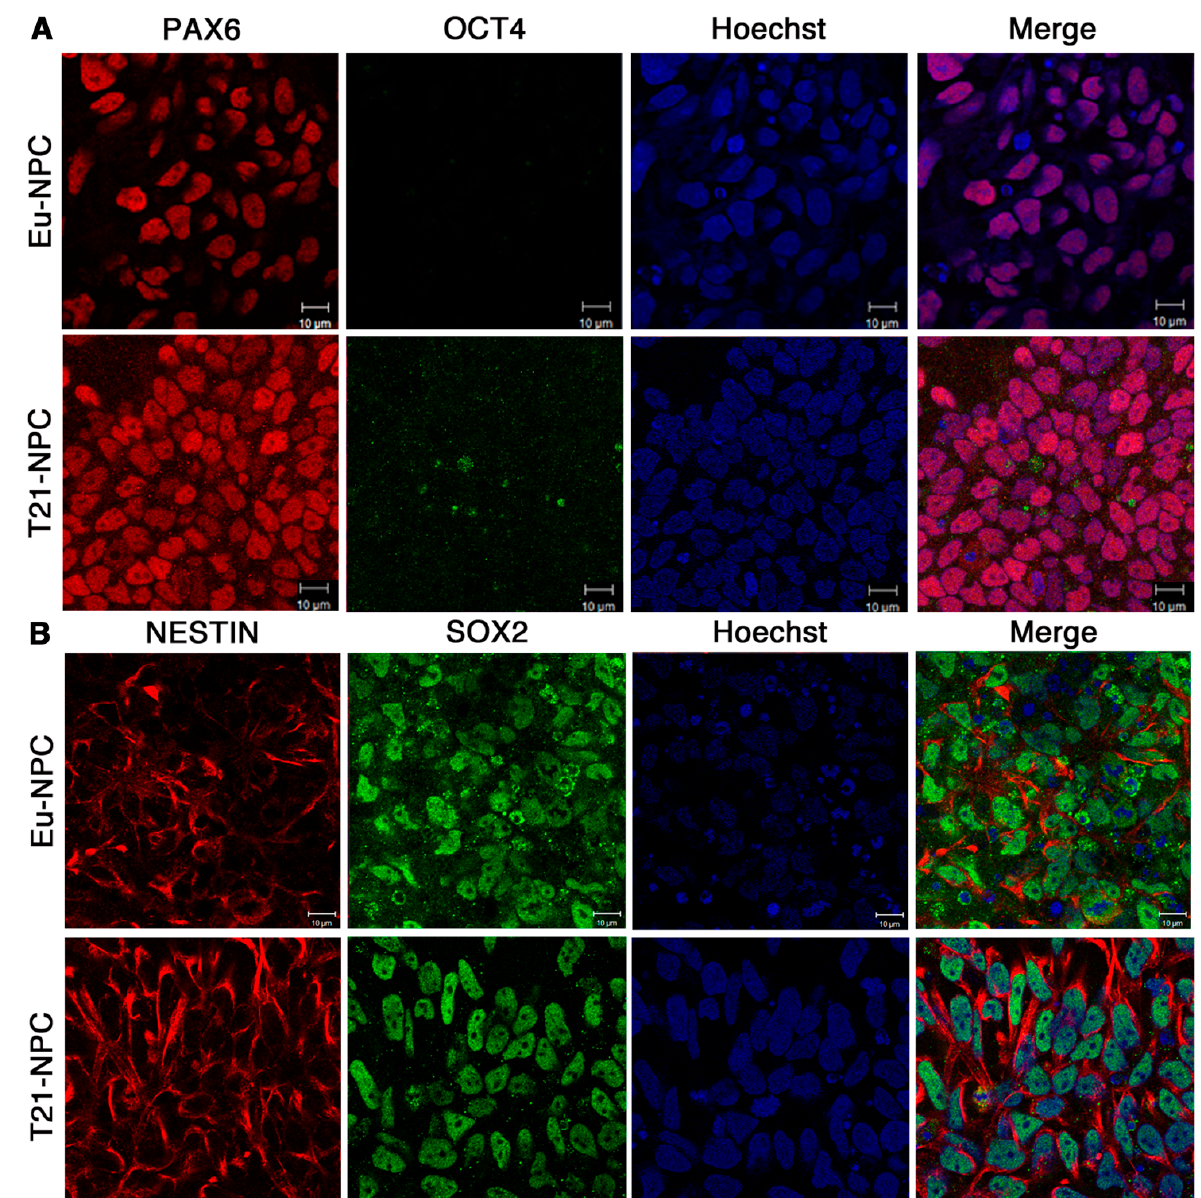
Figure 5. Expression of stemness and differentiation markers in iPSC-derived cells after seven days of neural induction. Expression of OCT4, PAX6, SOX2, and NESTIN was assessed by immunofluorescence in iPSCs after seven days of culture in differentiation medium. T21-NPC images are representative of the two trisomic clones. ( A ) Both euploid and trisomic cells are negative for OCT4 (green) and positive for PAX6 (red) staining. ( B ) Both cell types are positive when stained with NESTIN and SOX2 antibodies. The NESTIN antibody stains the intermediate filaments in the cytoplasm (red) while the SOX2 antibody stains this transcription factor in the nucleus (green). Nuclei are also stained with Hoechst (blue). Bar = 10 µ